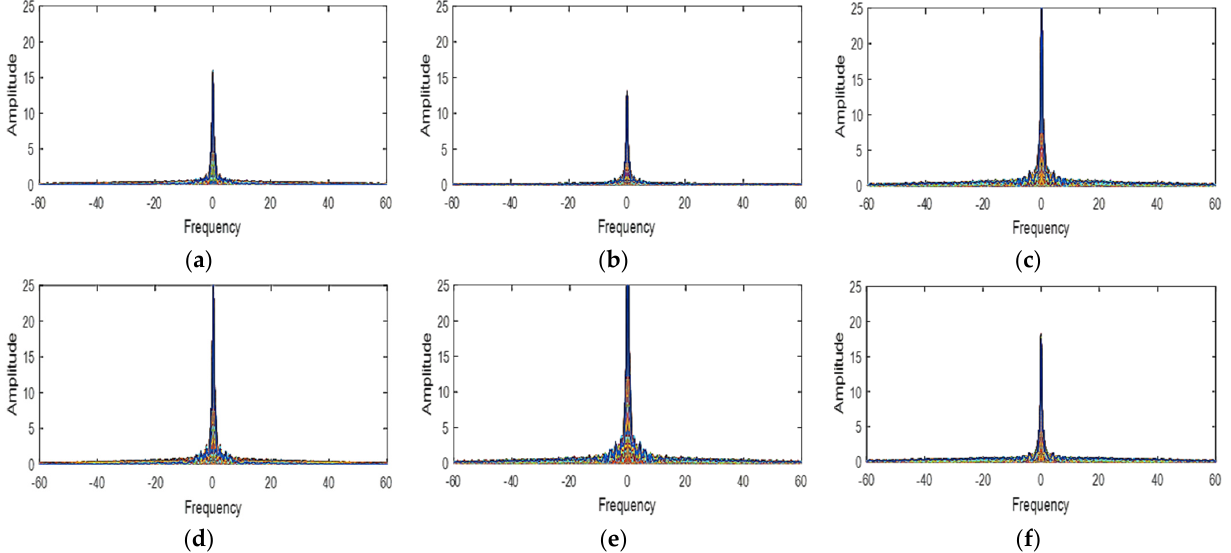
Figure 5. The power spectrum functions of the gradient signal in hairs image ( a ) green − red ( b ) green − blue ( c ) green − orange ( d ) red − blue ( e ) red − orange ( f ) blue − orange.